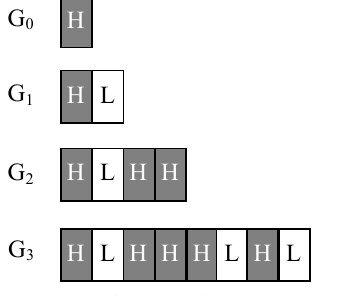
Figure 2: Generation of the Period-Doubling sequence Otherwise, the Period-Doubling, PD ..., are characterized by the inflation scheme: